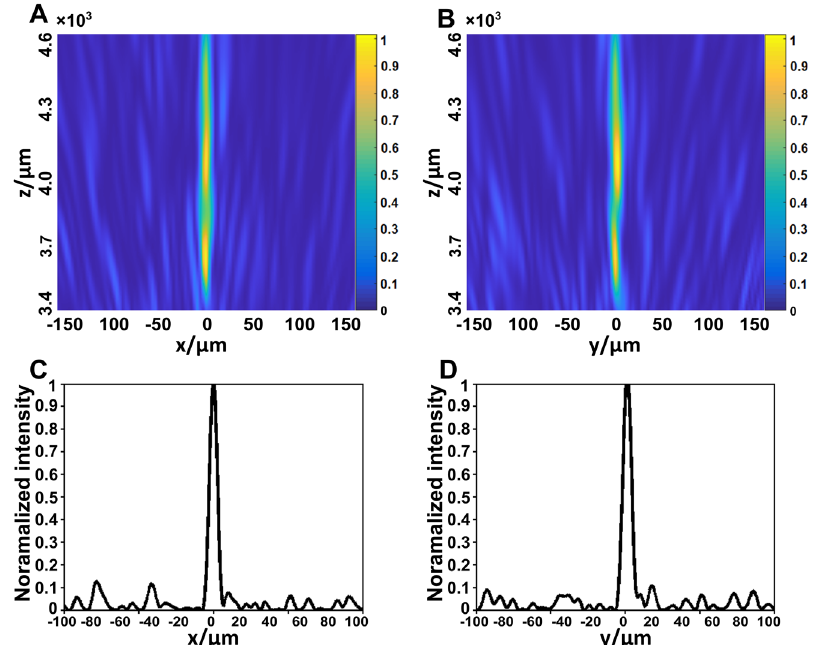
Figure 5: An optimized cylindrical mode generated by a 2D metasurface with (A) intensity profile of the mode in xz plane; (B) intensity pro fi le of mode in yz plane; (C) intensity distribution along the x axis at z = 4 mm; and (D) intensity distribution along the y axis at z = 4